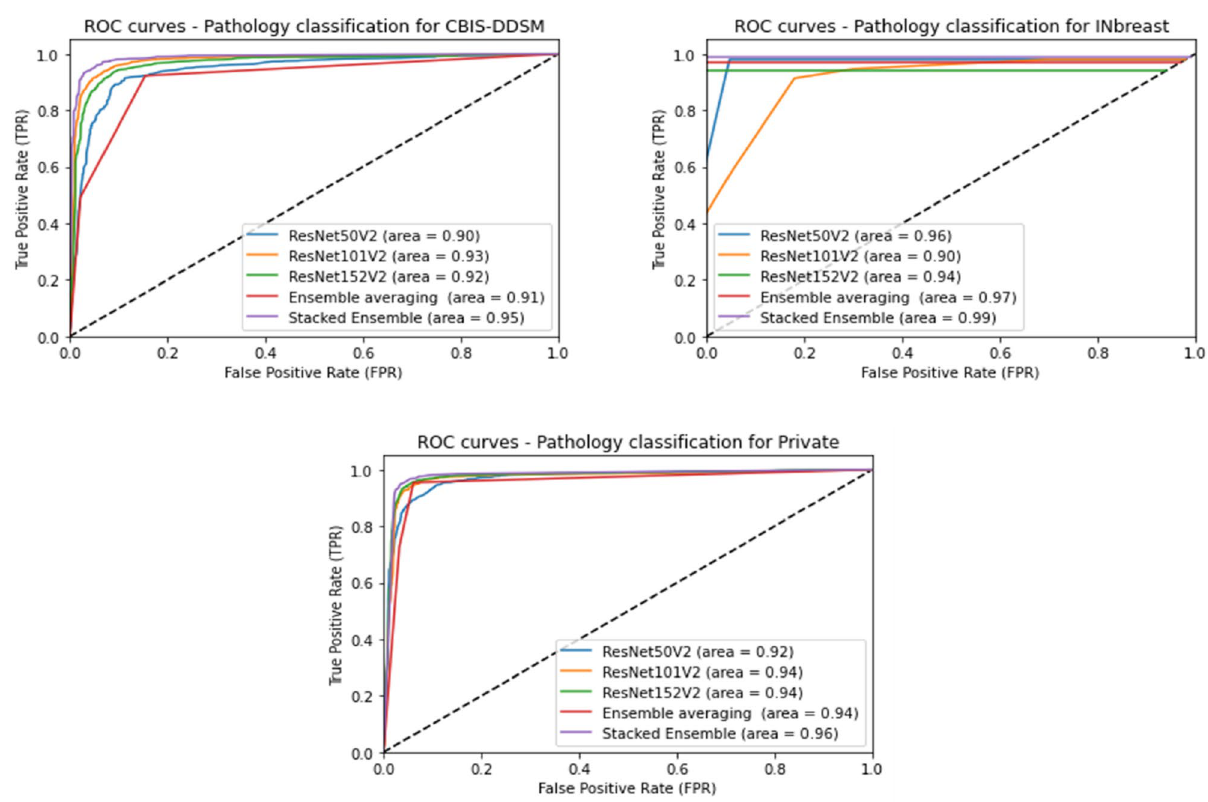
Figure 6. Performance of pathology classification using different models in terms of ROC curves and AUC